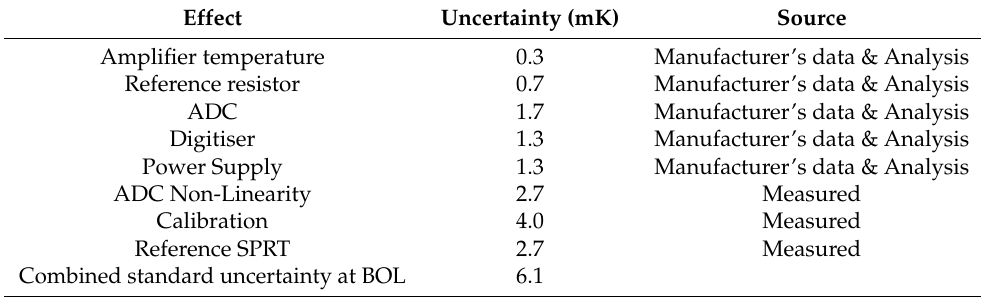
Table 4. SLSTR blackbody temperature measurement uncertainties at BOL from